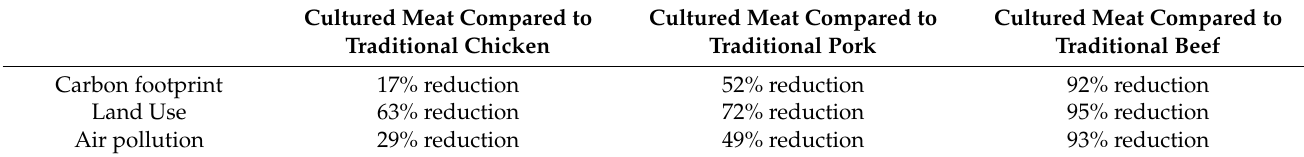
Table 1. The effect of cultivated meat production on selected environmental aspects: comparison with traditional meat production for three types of meat. (based on CE Delf TEA report, November